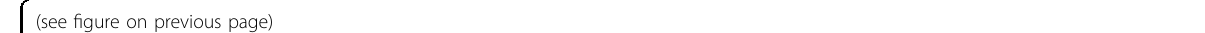
Fig. 1 OsSAPK6 positively regulates chilling tolerance in rice. a Plant morphologies of 2-week-old wild-type ZH11, ossapk6-1 and ossapk6-2 seedlings before treatment, after 4 °C treatment for 6 days, and subsequent recovery for 6 or 10 days. b Survival rates of ZH11, ossapk6-1, and ossapk6- 2 after 4 °C treatment as shown in a . c Ion leakage levels of ZH11, ossapk6-1 and ossapk6-2 after 4 °C treatment for 6 h. d Plant morphologies of 2- week-old ZH11, Ubi:OsSAPK6 and ossapk6-2 seedlings before treatment, after 4 °C treatment for 6 days, and subsequent recovery for 6 or 10 days. e Survival rates of ZH11, Ubi:OsSAPK6 and ossapk6-2 after 4 °C treatment as shown in d . f Ion leakage levels of ZH11, Ubi:OsSAPK6 and ossapk6-2 after 4 °C treatment for 6 h. In b , c , e , and f , values are means ± SD ( n = 3 biological replicates), and the asterisks indicate signi fi cant differences compared with the ZH11 (** P < 0.01, Student ’ s t- test). Bars = 5 cm in a and d . See also Supplementary Figs. S1 and